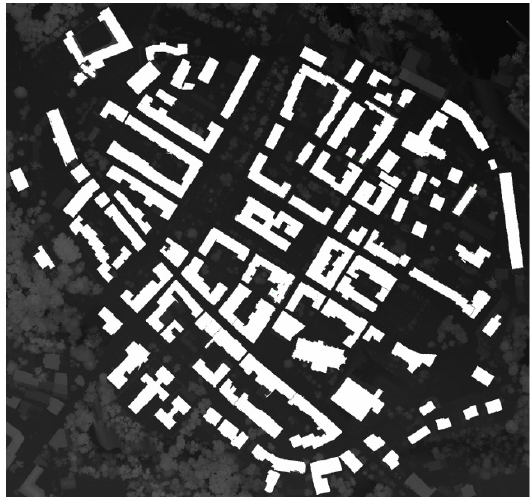
Figure 4d. Initial outlines.